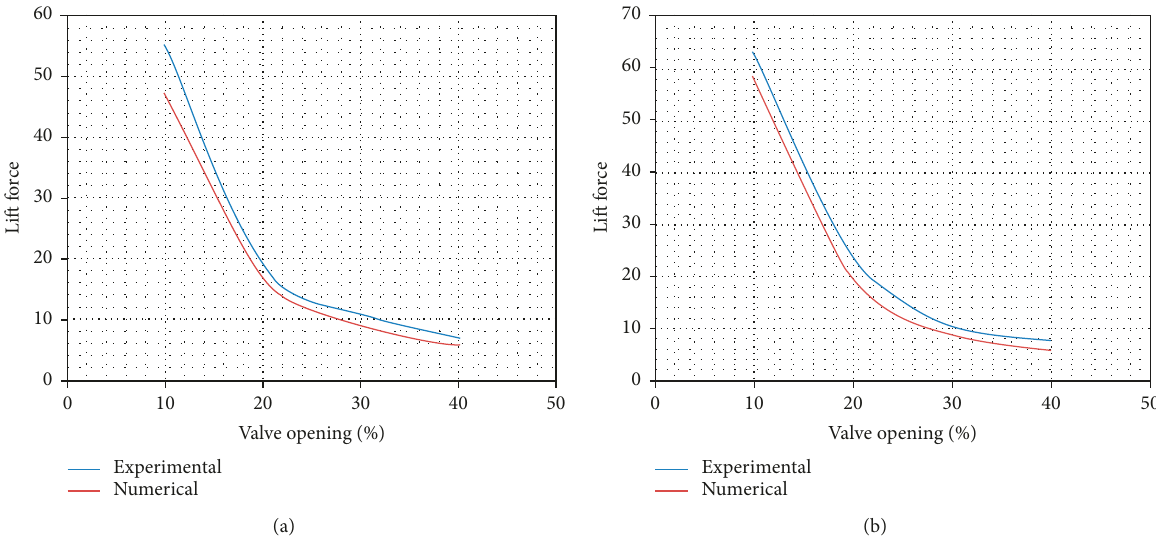
Figure 20: Relation between lift force acting on flat-faced plug and the percentage regarding valve opening at inlet velocity of 1m/s for present FSI and experimental